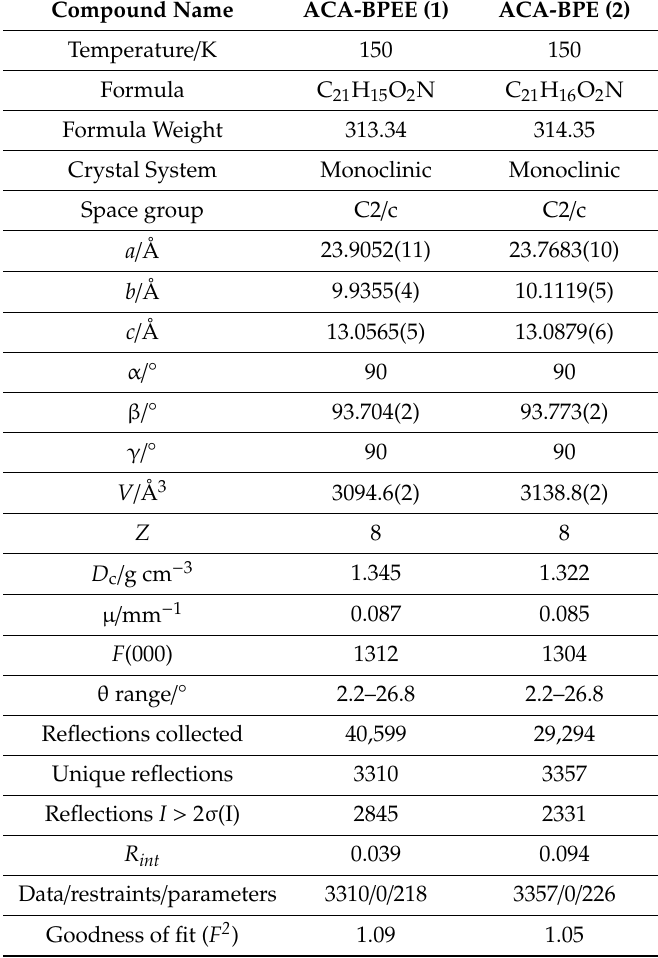
Crystallographic and structural refinement parameters of 9-anthracene